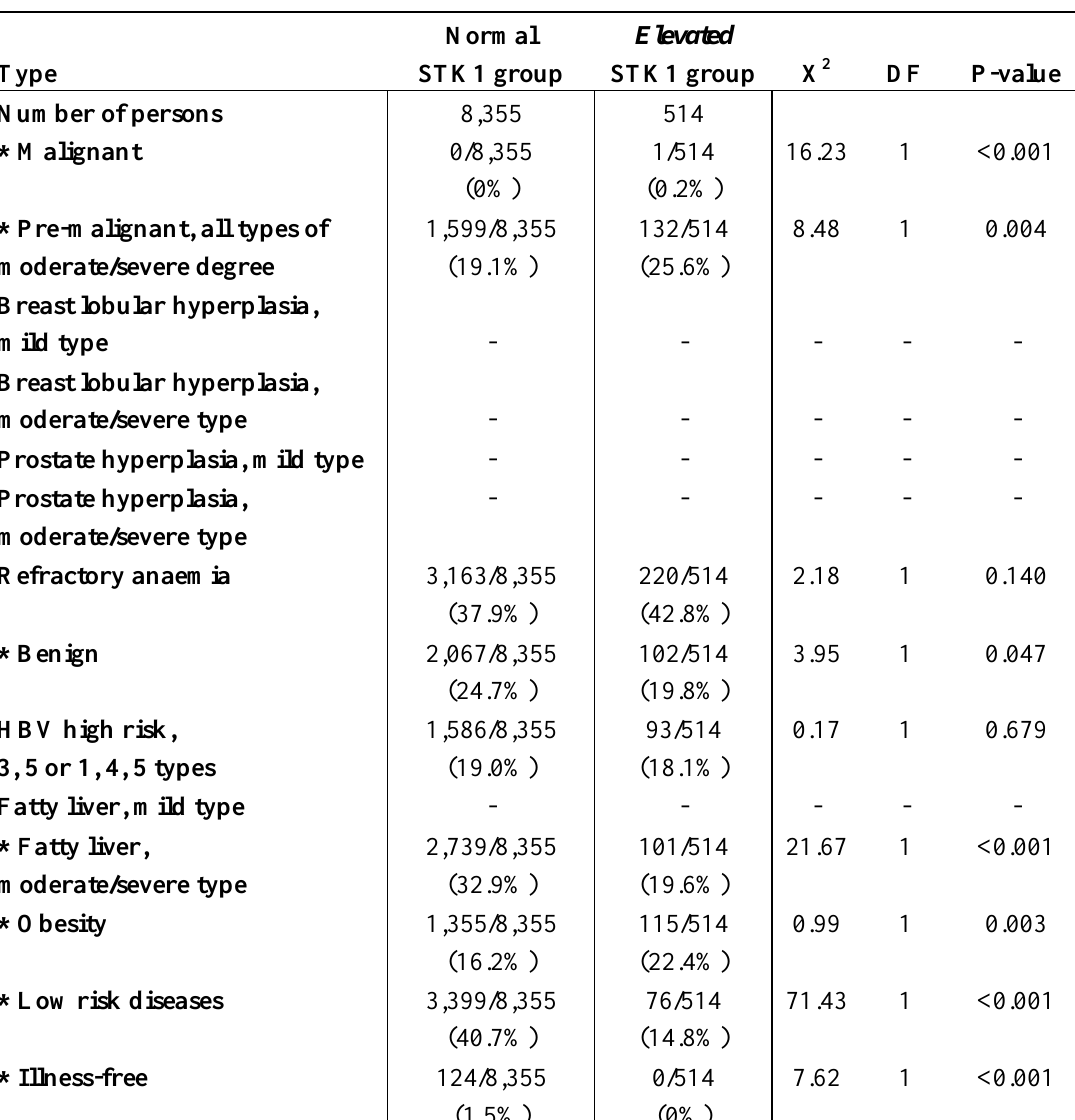
Table 6. Number of oil-field work ers of the normal and elevated STK1 groups by various diseases. The malignancy in the elevated STK1 group was of early tumour stage. The low-risk diseases consist of HBV score types 2, 4, 5 or 2, 5; mild degree of hyperplasia; cervical erosion; gastric ulcer; and fatty liver of low risk. The illness-free group was defined as no detectable diseases or illness. The statistical calculations were done by chi-square test. The stars ( * ) indicate groups of statistically significant differences. (-) = no data.